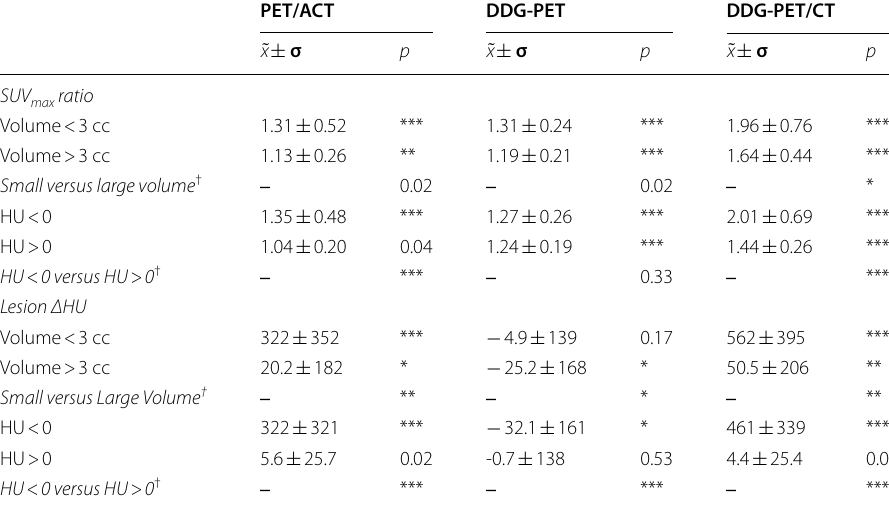
Table 3 SUV ratio and ΔHU comparisons for various groups of max